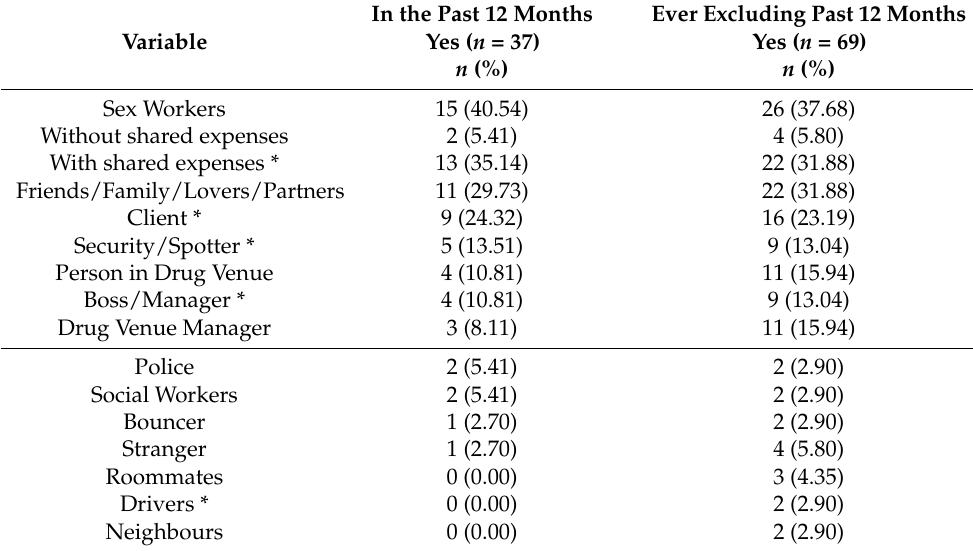
Table 3. Descriptive proportions of persons sex workers reported assisted them to escape situations of violence and confinement among those who were assisted to escape these